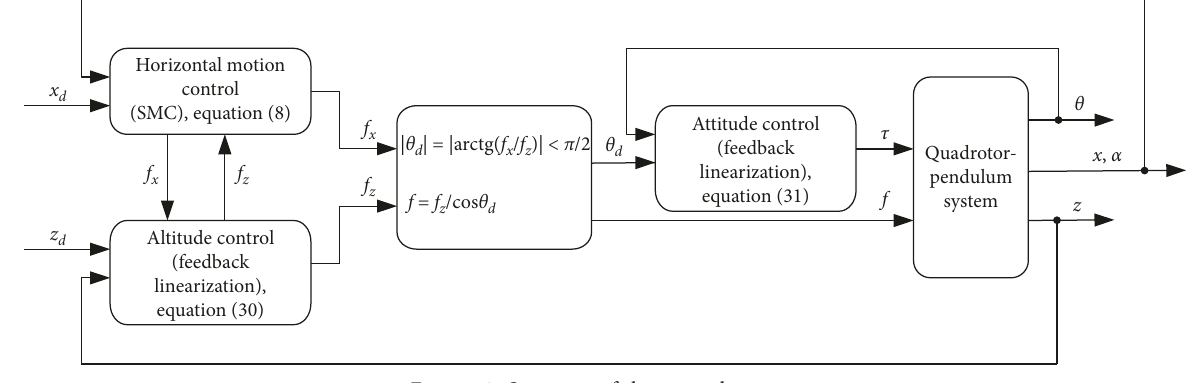
Figure 2: Structure of the control